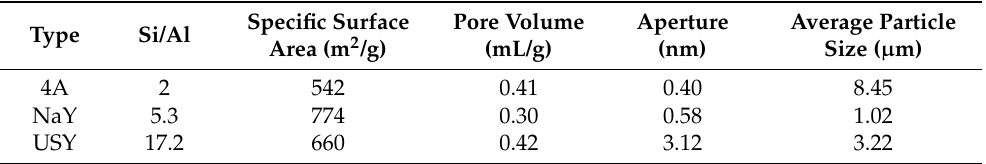
Table 2. Basic physical and chemical properties of